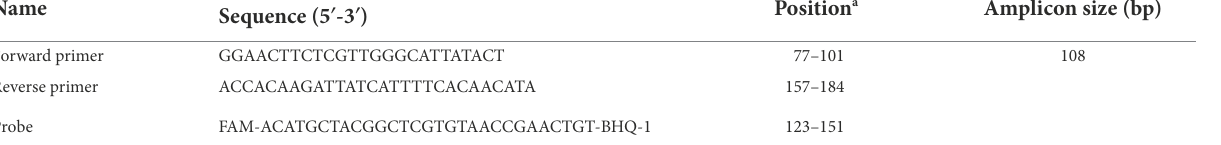
TABLE 2 The sequences of primers and probe used in the RT-qPCR